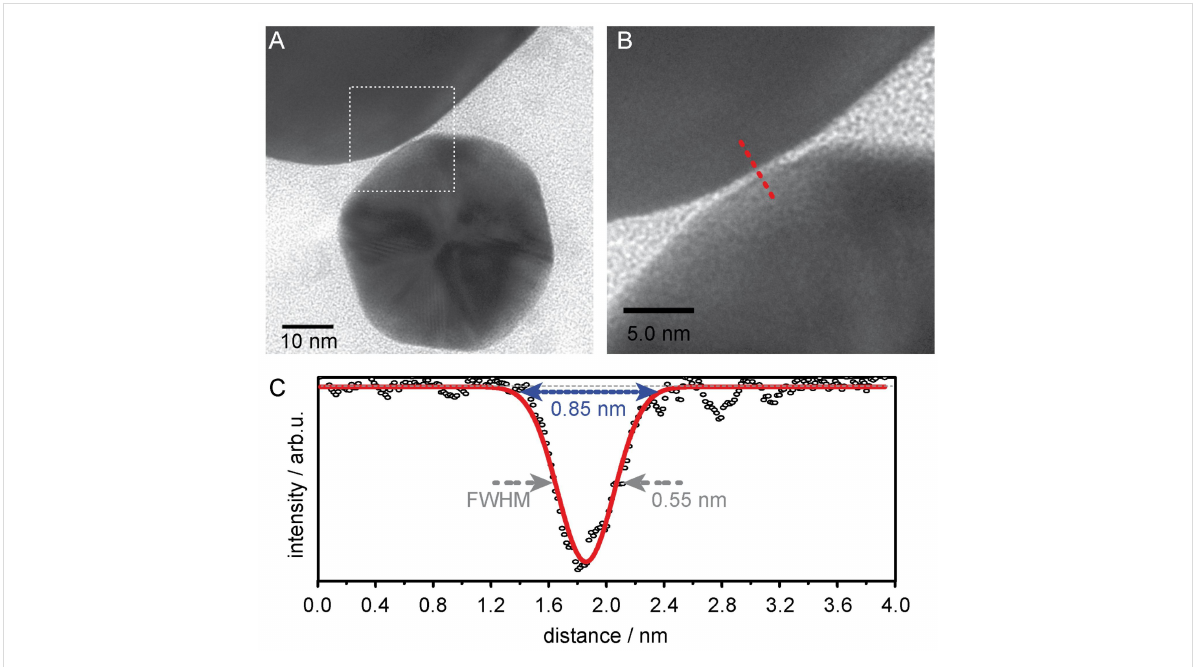
Figure 5: Gap size of CB[8] mediated 40–80 nm AuNP dimers. (A) TEM image of a dimer with sub-nanometer gap size. (B) High-magnification TEM image of the gap region. (C) Line-profile drawn across the gap (red dotted line in